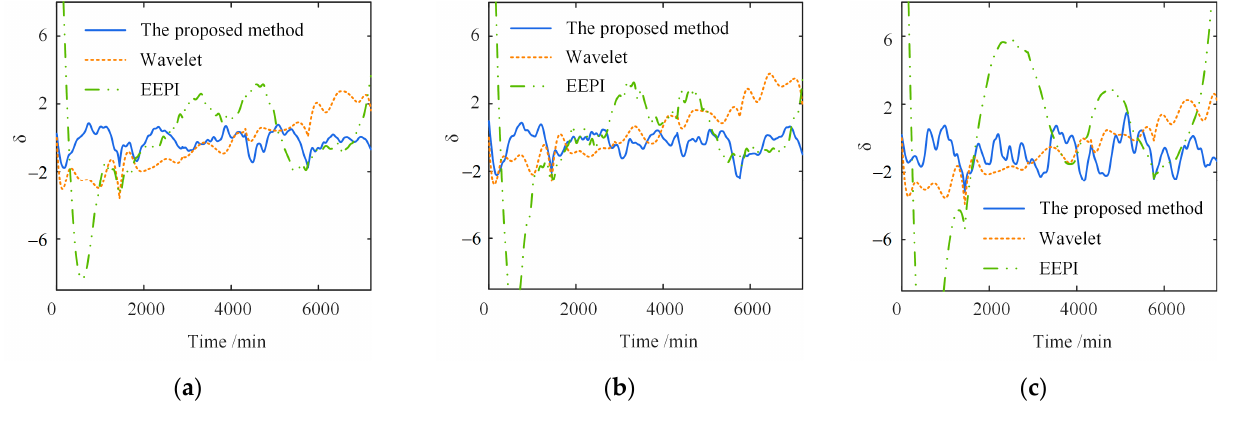
Figure 13. Separation error under different degrees of noise (five days): ( a ) e p = 5%; ( b ) e p = 10%; ( c ) e p = 20%.